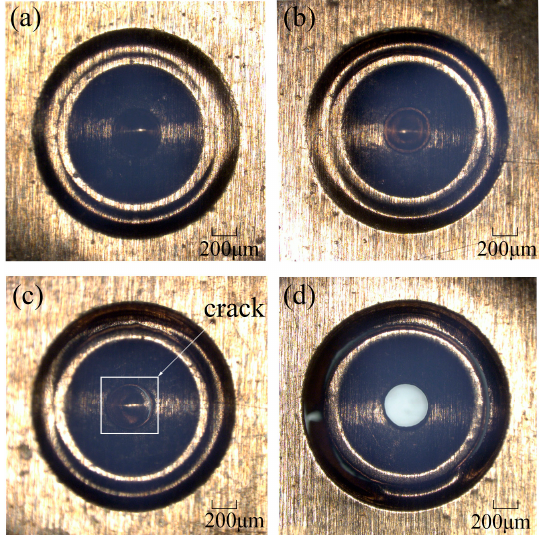
Figure 4. Two-dimensional plot of the work piece when the laser energy is ( a ) 565 mJ; ( b ) 675 mJ; ( c ) 835 mJ; ( d )1200 mJ.